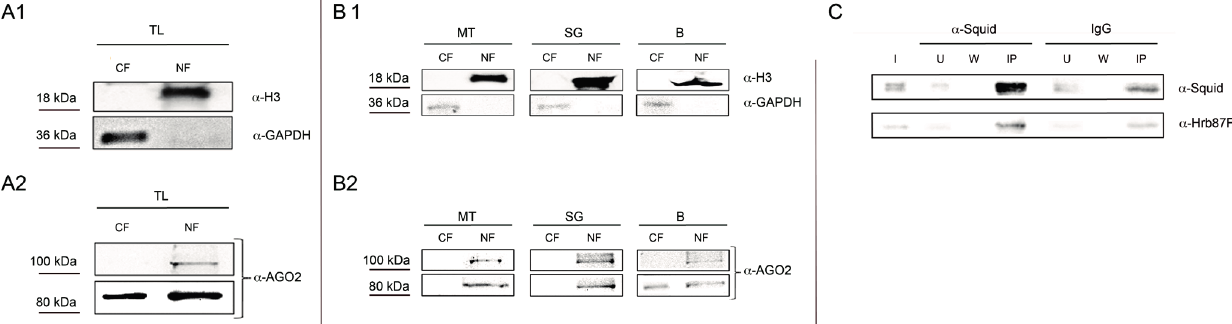
Figure 2. In vitro and in vivo analysis of proteins extracted from Drosophila ’s small quantity of whole larva and tissues. Western Blot analysis of proteins extracted from WL to detect any contamination of cytoplasmic proteins in nuclear fractions and vice versa . The same amount (3 μ g) of different protein fractions is used in an immunodetection assay with two different antibodies: anti- α H3 (1:4000) and anti-GAPDH (1:4000) ( A1 ). The same extracts are used in an immunodetection assay with anti-AGO2 (1:2000) ( A2 ); ( B1 ) Western Blot analysis of proteins extracted from different Drosophila ’s tissues like MT, SG and B. ( B2 ) 3 μ g of nuclear and cytoplasmic protein fractions are used in an immunodetection assay with anti-AGO2 (1:2000), anti- α H3 (1:4000), and anti-GAPDH (1:4000); ( C ) Co-immunoprecipitation of Squid and Hrb87F hnRNPs from nuclear extracts. The same amount of nuclear protein fractions is used in an immunoprecipitation assay with anti-Squid antibody and IgG. For the immunodetection assay anti-Squid (1:200) and anti-Hrb87F (1:4000) were used. I = Input, U Squid = Unbound from anti-Squid IP, W Squid , wash from anti-Squid IP, U IgG = Unbound from IgG IP, W IgG , wash from anti-IgG IP, IP Squid = Immunoprecipitated material from anti-Squid, IP IP IgG = Immunoprecipitated material from IgG